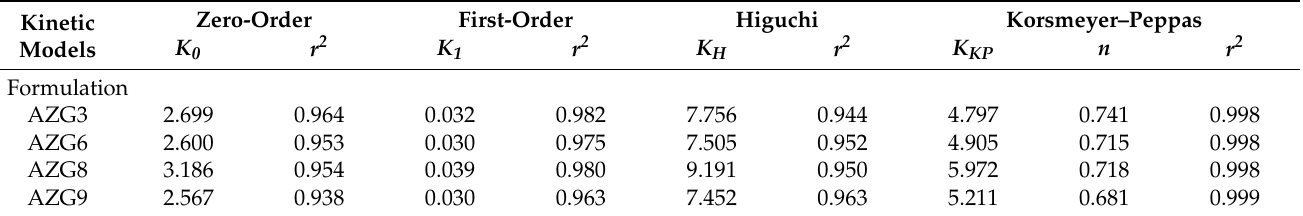
Table 4. Kinetic model fitting of AZG